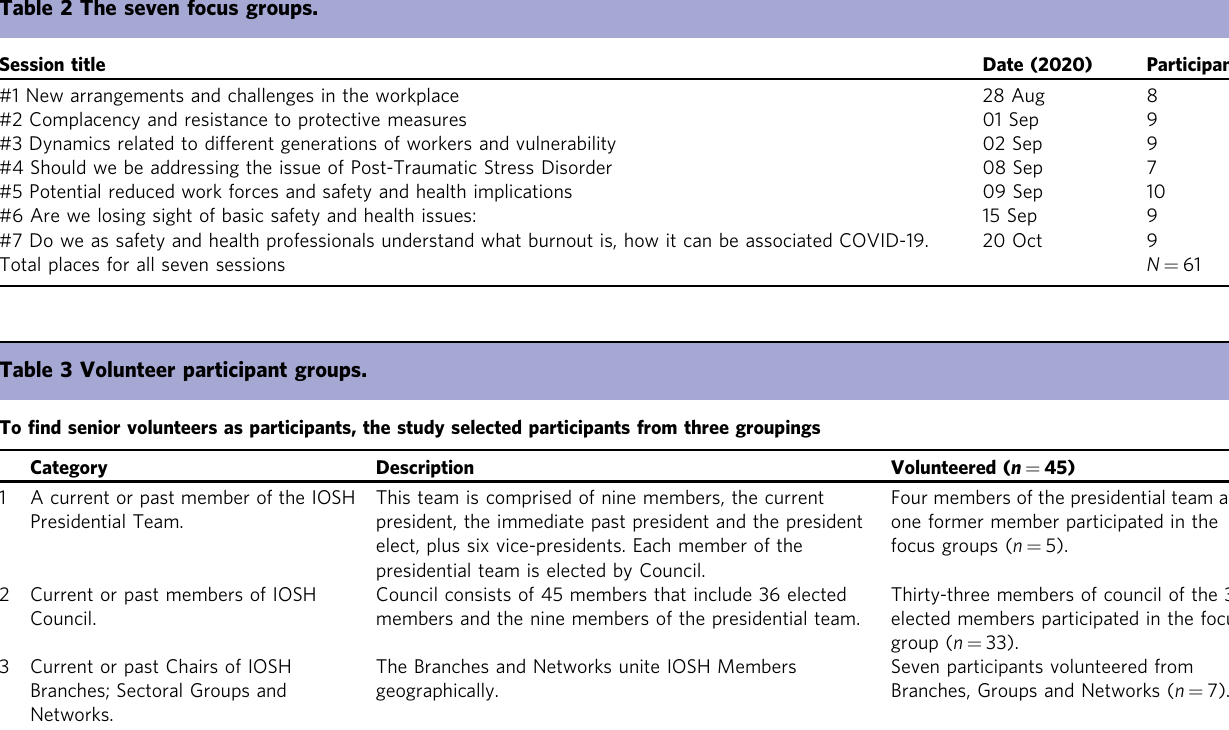
Table 2 The seven focus groups.